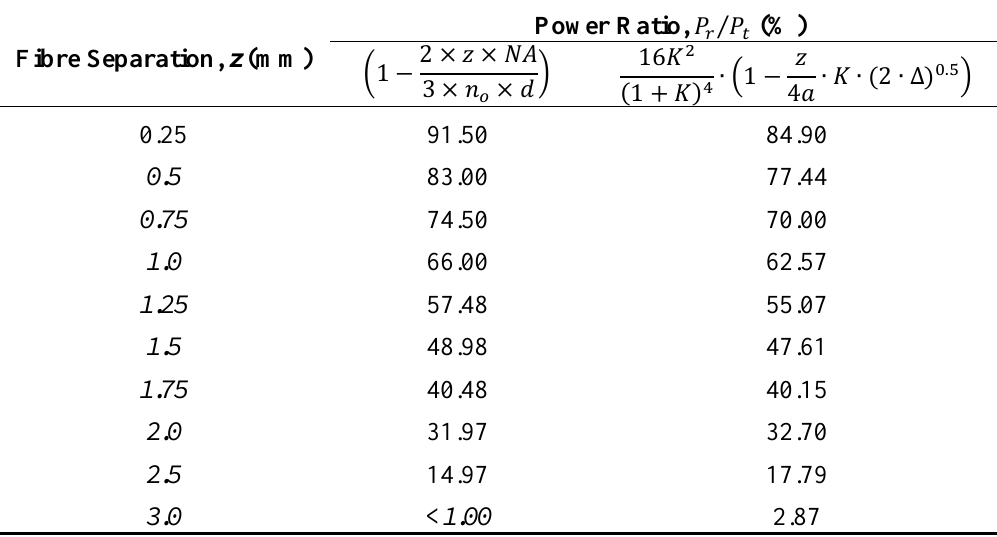
Table 1. Transmitted power ratio estimation due to fibre separation